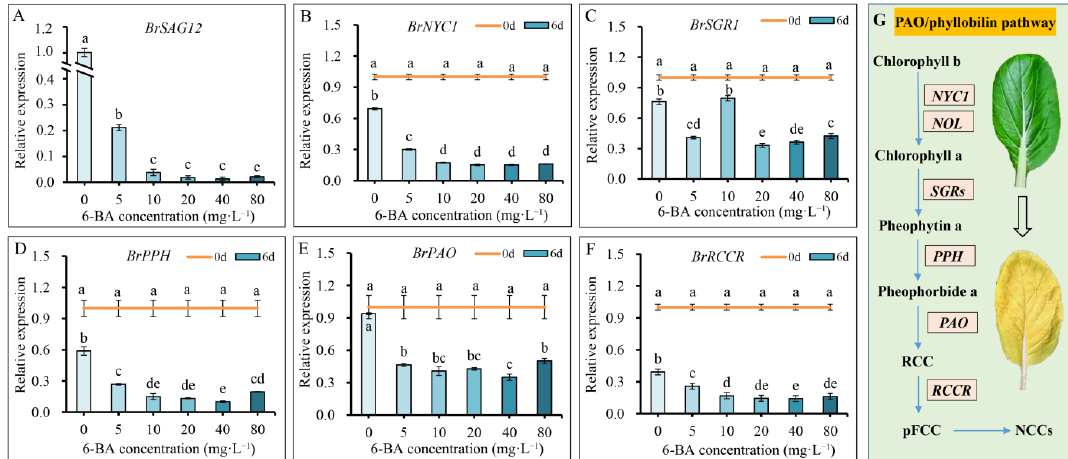
Figure 2. Chlorophyll degradation-related gene expression in Chinese flowering cabbage treated with different 6-BA after harvest. Changes in the transcript levels of BrSAG12 ( A ), BrNYC1 ( B ), BrSGR1 ( C ), BrPPH ( D ), BrPAO ( E ), and BrRCCR ( F ). The PAO/phyllobilin pathway of chlorophyll degradation in plant leaf ( G ). Each bar indicates the mean ± standard deviation of three biological replicates, and different lowercase letters indicate significant differences between Chinese flowering cabbage under different treatments ( p < 0.05).